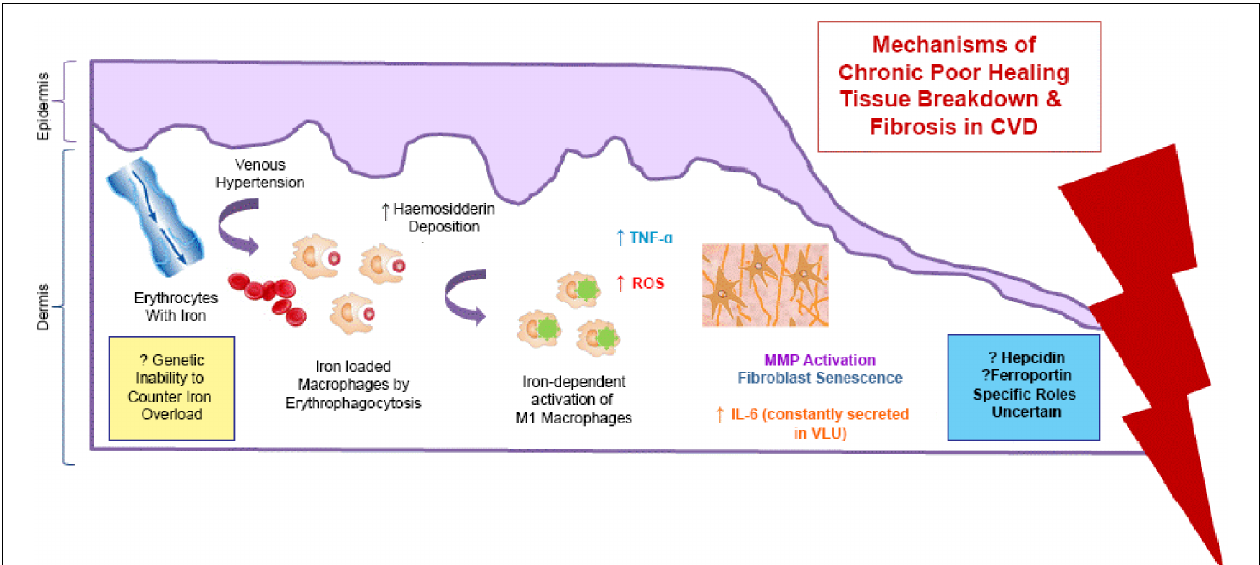
produced cause a cascade of deleterious reactions and increase oxidative stress. There is further inflammatory response through tumor necrosis factor alpha (TNF- α ) and interleukin-6 (IL -6) which is constantly secreted venous leg ulceration (VLU). Dermal fibrosis is the result of matrix metalloproteinase (MMP) activation and fibroblast